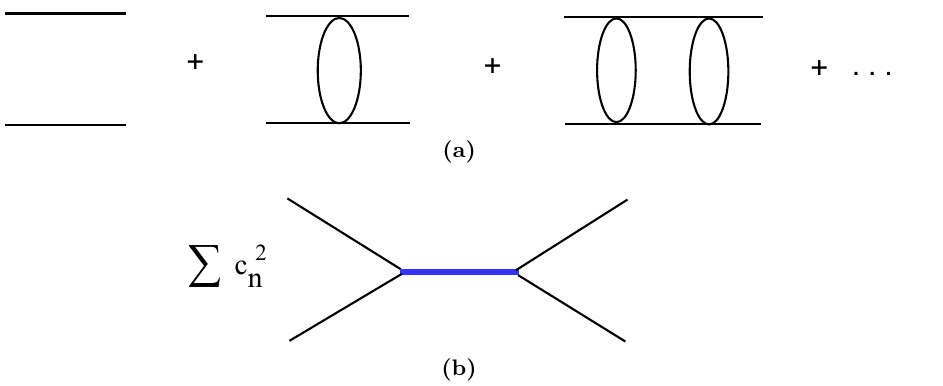
Figure 4. (a) The fermion four-point function, at order 1 =N , is a sum of ladder diagrams. (b) It can be represented as a sum of conformal blocks, involving the O n